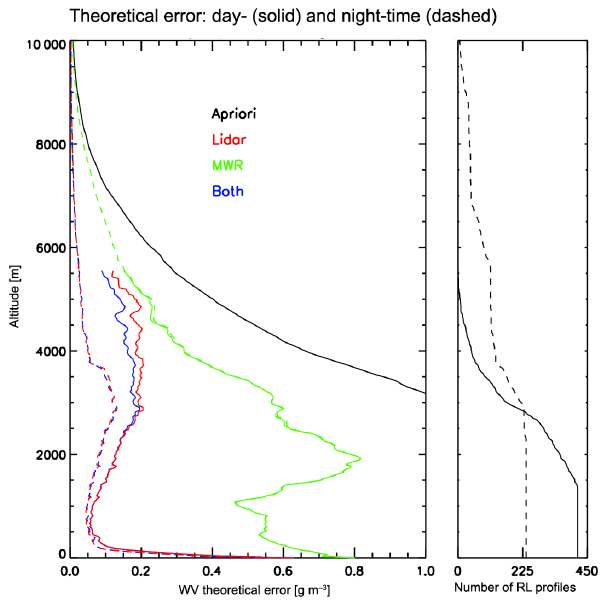
Figure 7. Left: mean theoretical error over the 636 clear sky cases during the complete HOPE period, separated into daytime (solid) and nighttime (dashed) measurements. In black: a priori uncertainty (lowest 3km are out of margins). Red: only-RL. Green: only MWR. In blue: the MWR+RL. Right: number of RL profiles reaching each altitude, corresponding to the number of profiles used to calculate the average in the left